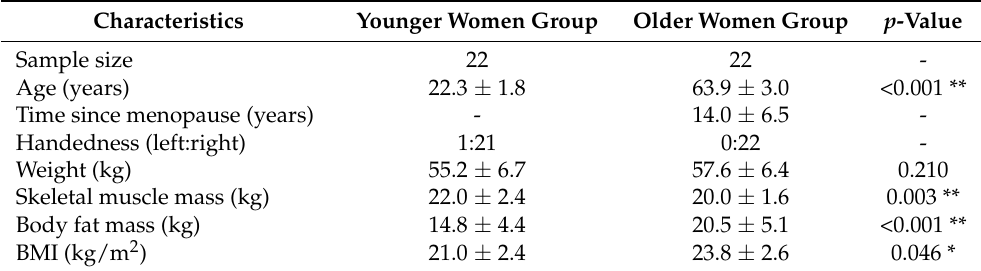
Table 1. Demographic and clinical information for participants.